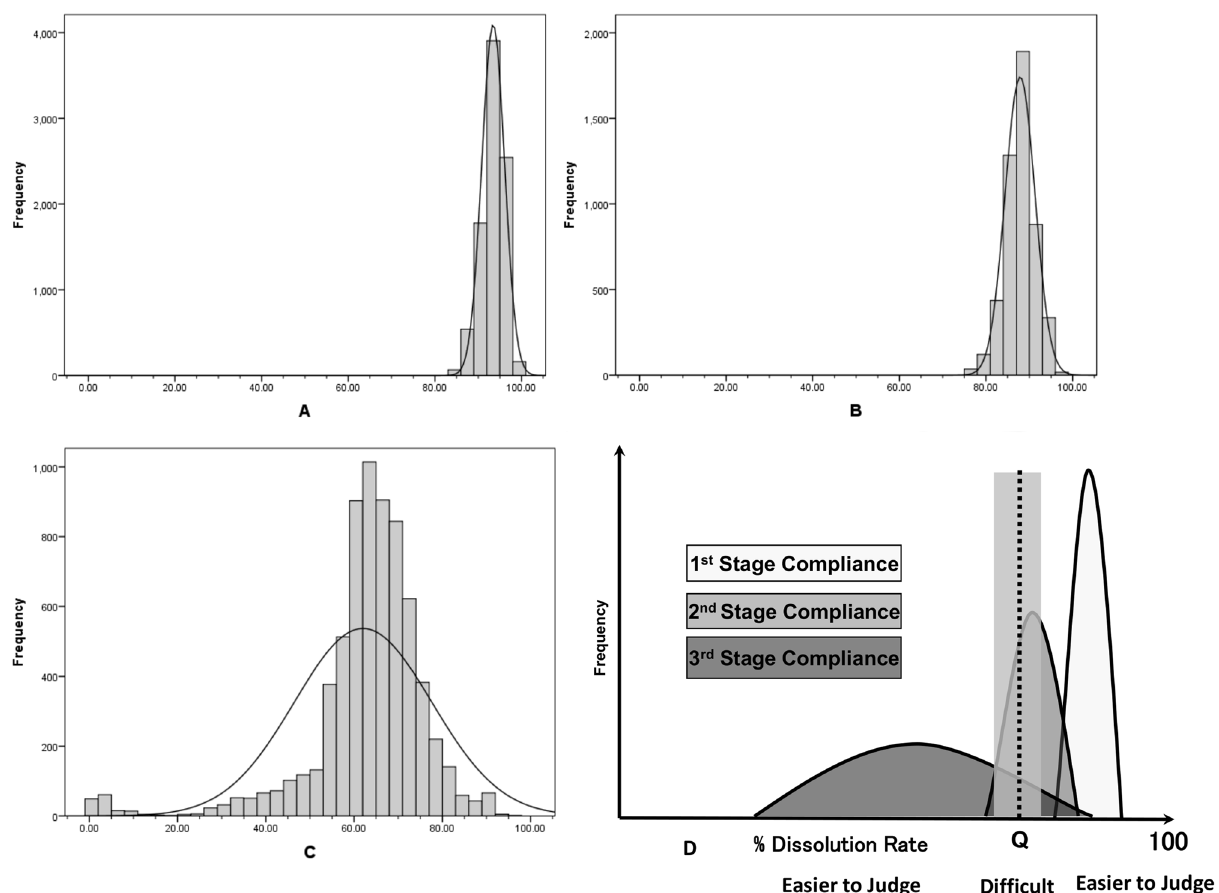
Figure 4. Sampling distributions for the three stages of the USP dissolution test. ( A ) First stage. ( B ) Second stage. ( C ) Third stage. ( D ) Judgement concordance rate at each stage. 1st stage compliant